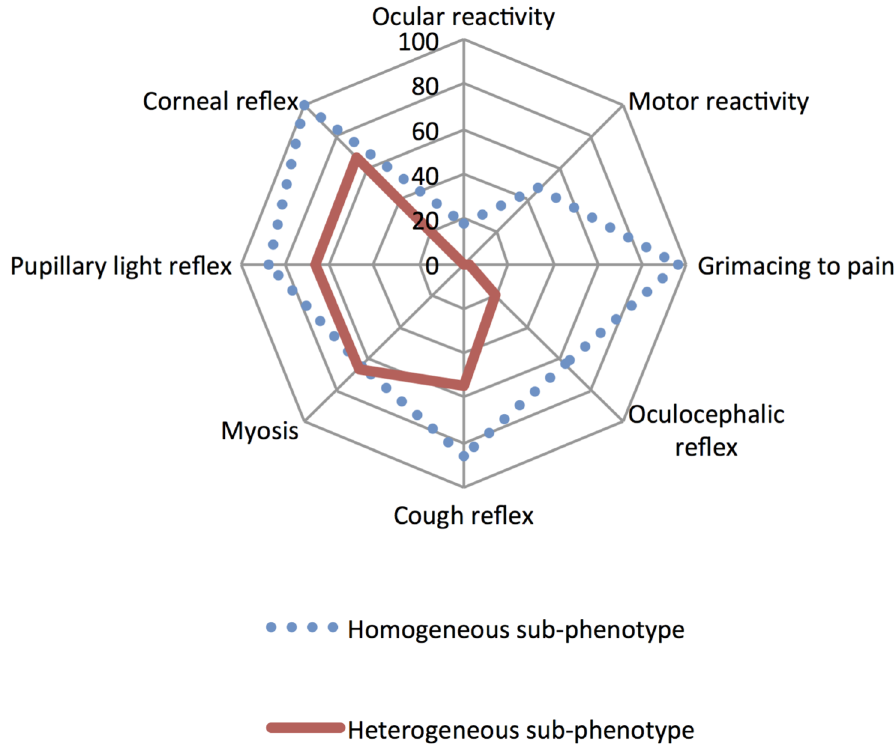
Fig 2. Representation of homogeneous and heterogeneous profiles. The percentage of abolitionof each tested neurologicalresponses in homogeneous and heterogeneous profilesare depicted. The heterogeneous profile is characterized by a greater and more heterogeneous abolitionof neurological responses.